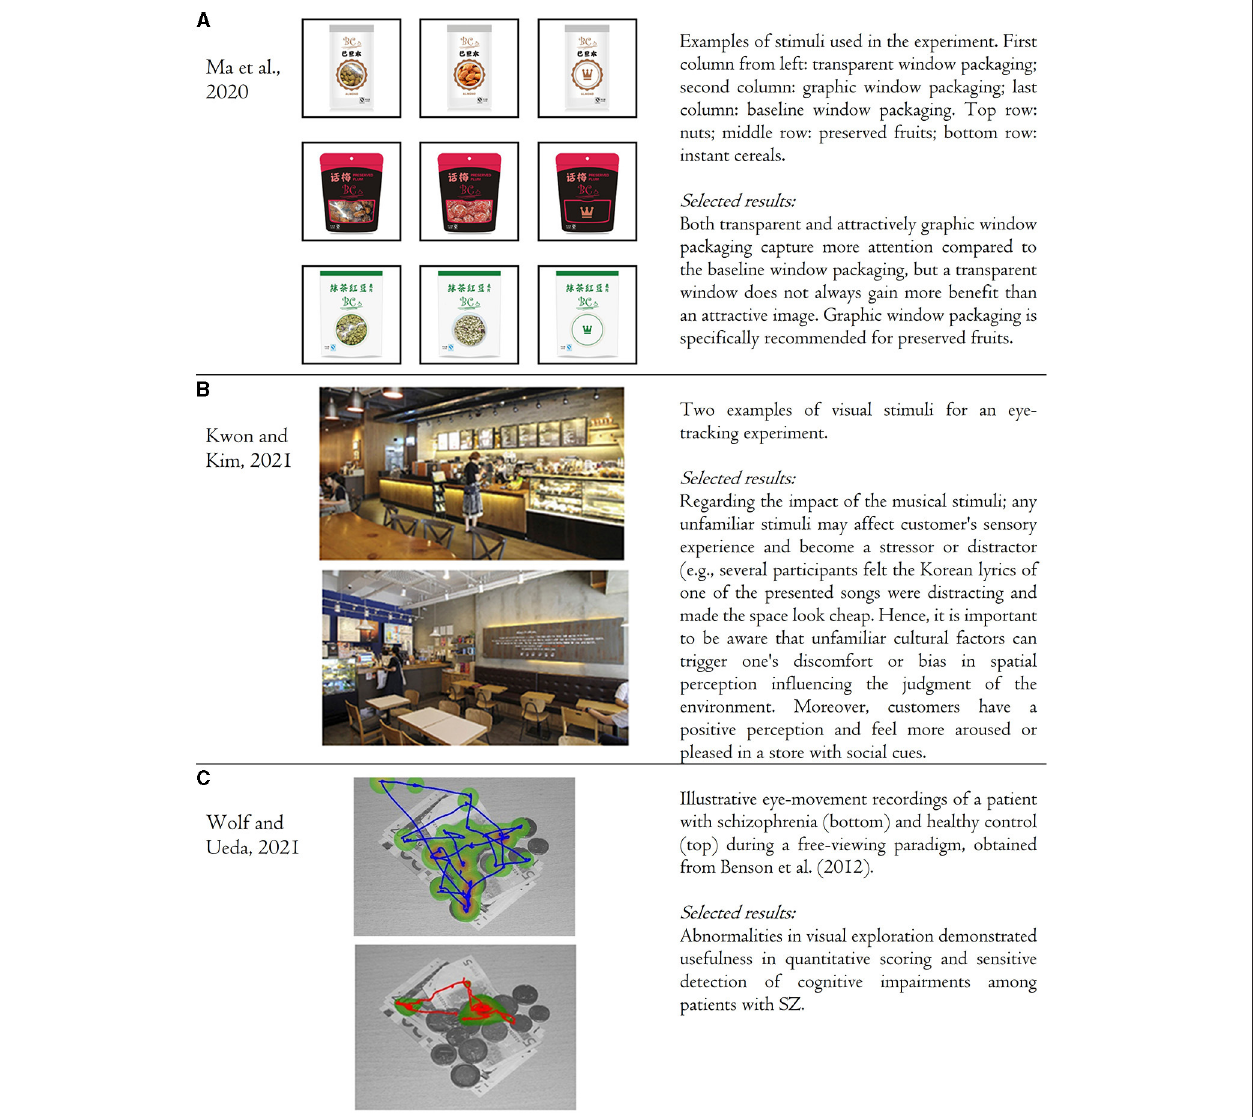
FIGURE 1 | Application of eye-tracking technology in product packaging (A) , design of commercial stores (B) , and detection of cognitive impairments among clinical populations (C) .